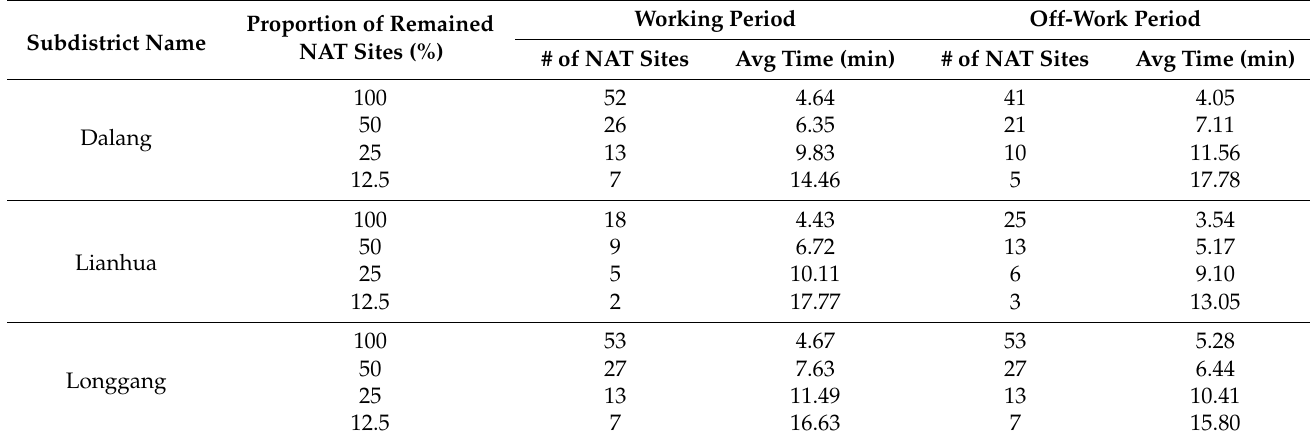
Table 3. Data statistics of the population covered by NAT sites service area.